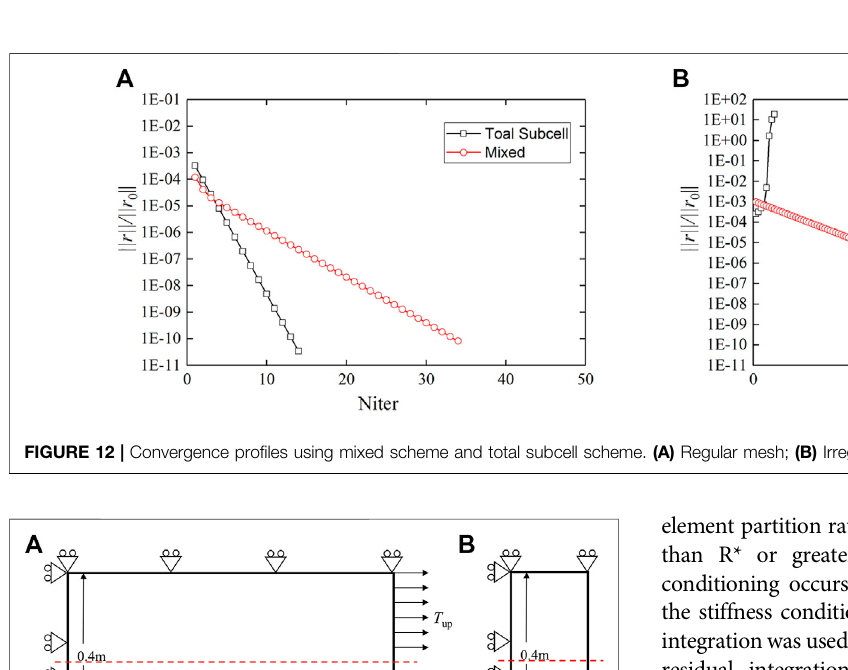
Frontiers in Earth Science |